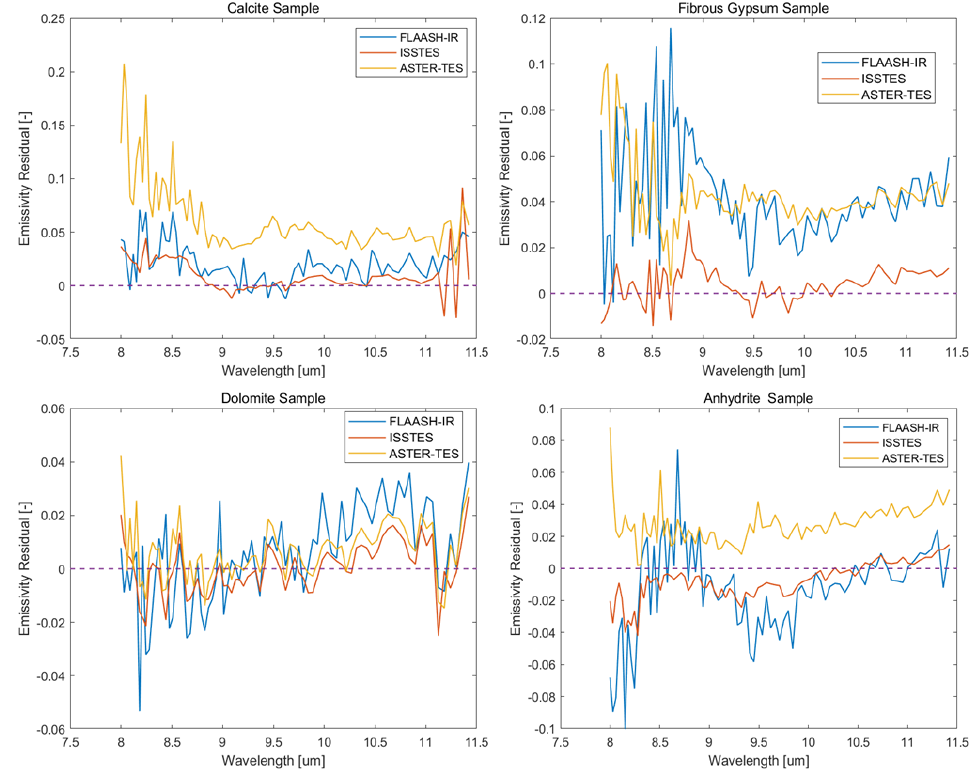
Figure 15. The SRs of the retrieved emissivity of FLAASH-IR, ISSTES, and modified ASTER-TES and the standard emissivity spectra measured by a Model 102F spectrometer.